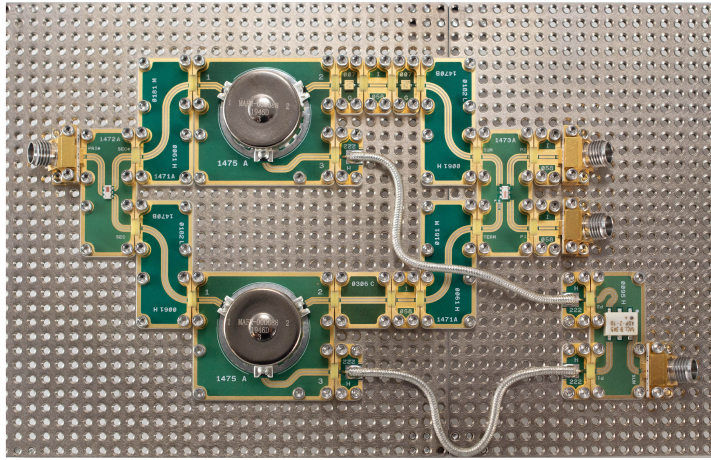
Figure 10. Overview of the circuit from